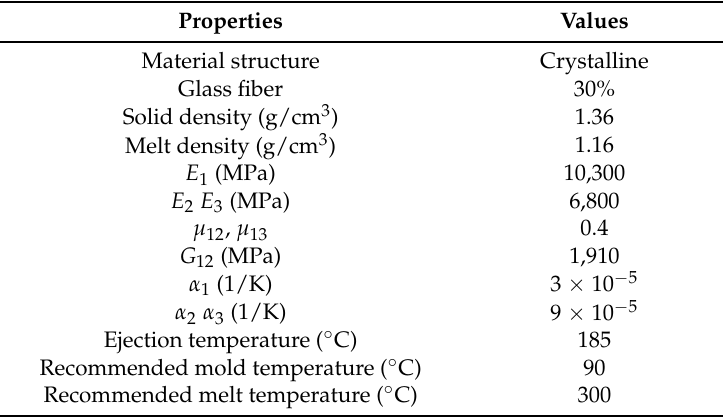
Table 1. Properties of PA66 (glass fiber reinforced polyamide 66) (GF